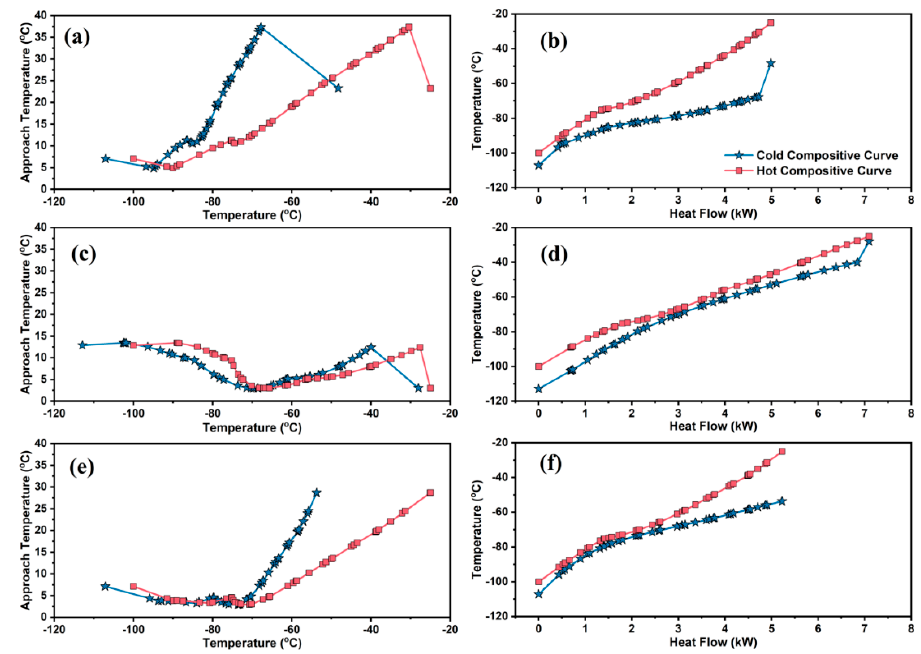
Figure 5. Temperature difference composite curves (TDCC) and temperature–heat flow composite curves (THCC) of ( a ) and ( b ) the base case, ( c ) and ( d ) SCE optimized process corresponding to 300 iterations and ( e ) and ( f ) SCE-optimized process corresponding to 700 iterations, for the liquefaction heat exchanger of MFC–LNG process.